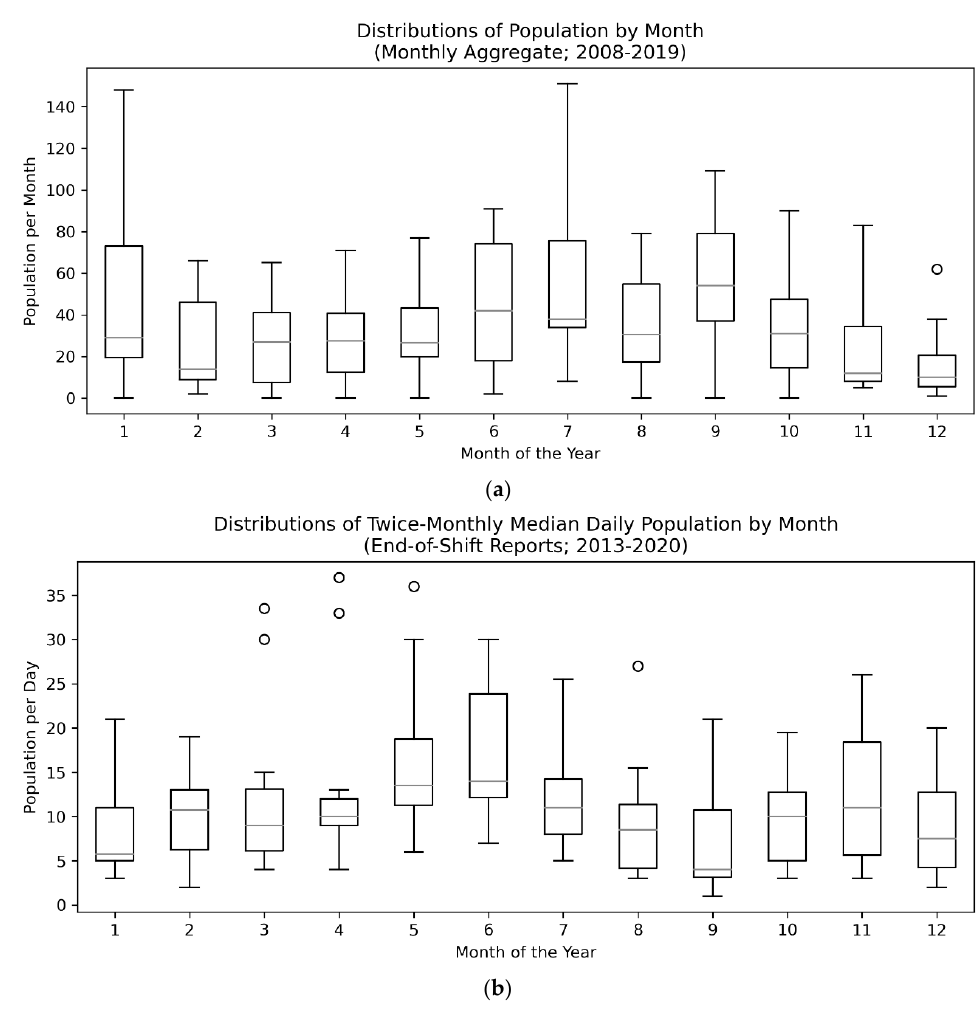
Figure 3. Box and whisker plots of Monthly Aggregate (N = 5127; 2008–2019) ( a ) and End-of-Shift Report (N days = 2474; 2013–2020) ( b ) data showing clear seasonal trends in the number of Canine parvovirus (CPV)-infected dogs peaking in the summer months. Circles indicate outlier points with interquartile range greater than 1.5 (i.e. Q3 + 1.5 × (Q3–Q1) for the upper bound).